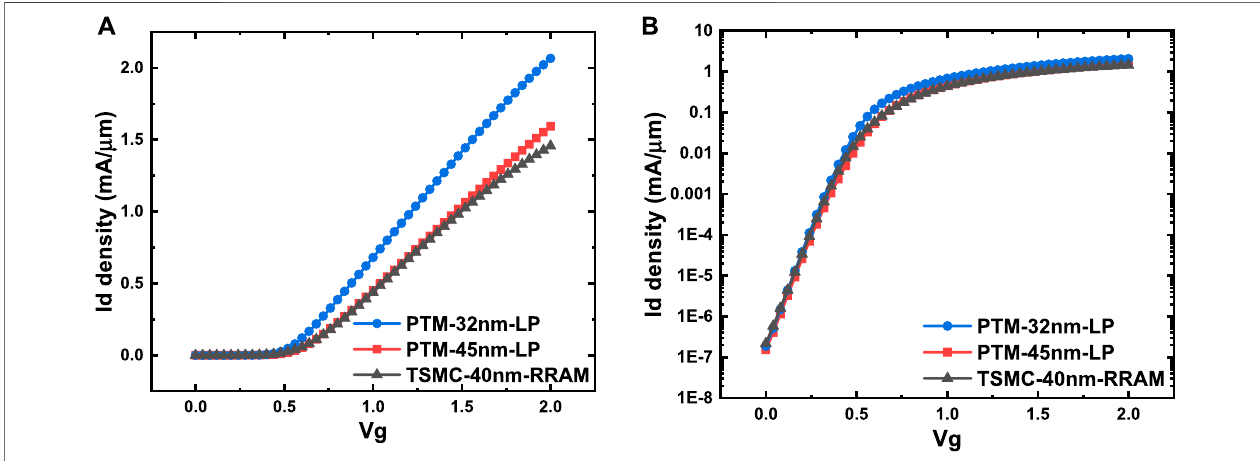
Frontiers in Arti fi cial Intelligence |